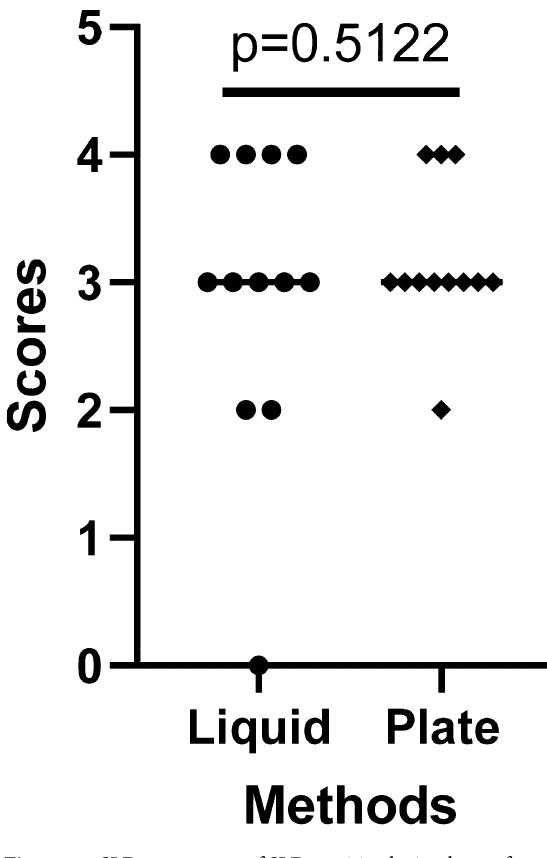
Figure 5. SLD spot scores of SLD-positive laying hens after challenge with C. hepaticus HV10 T grown from modified Brucella broth (liquid method) and HBA plate method based on scores of spots. This score is based on a logarithmic scale from 0 to 4, where 0 = no visible lesions, 1 = 1–9 lesions, 2 = 10–99 lesions, 3 = 100–999 lesions and 4 = more than 1000 lesions. P values were calculated using unpaired